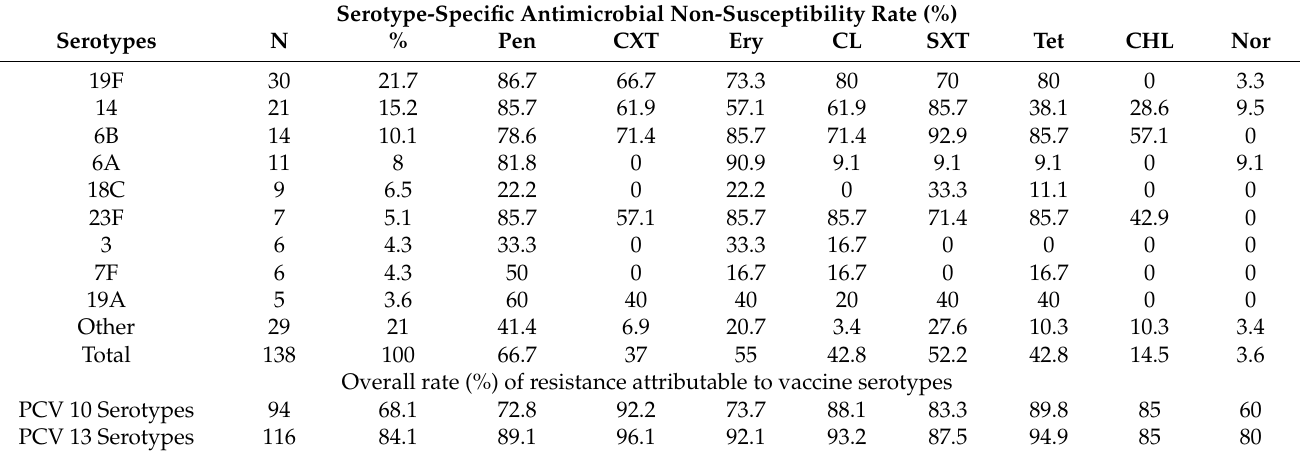
Table 3. Serotype-specific antimicrobial susceptibility of S. pneumoniae